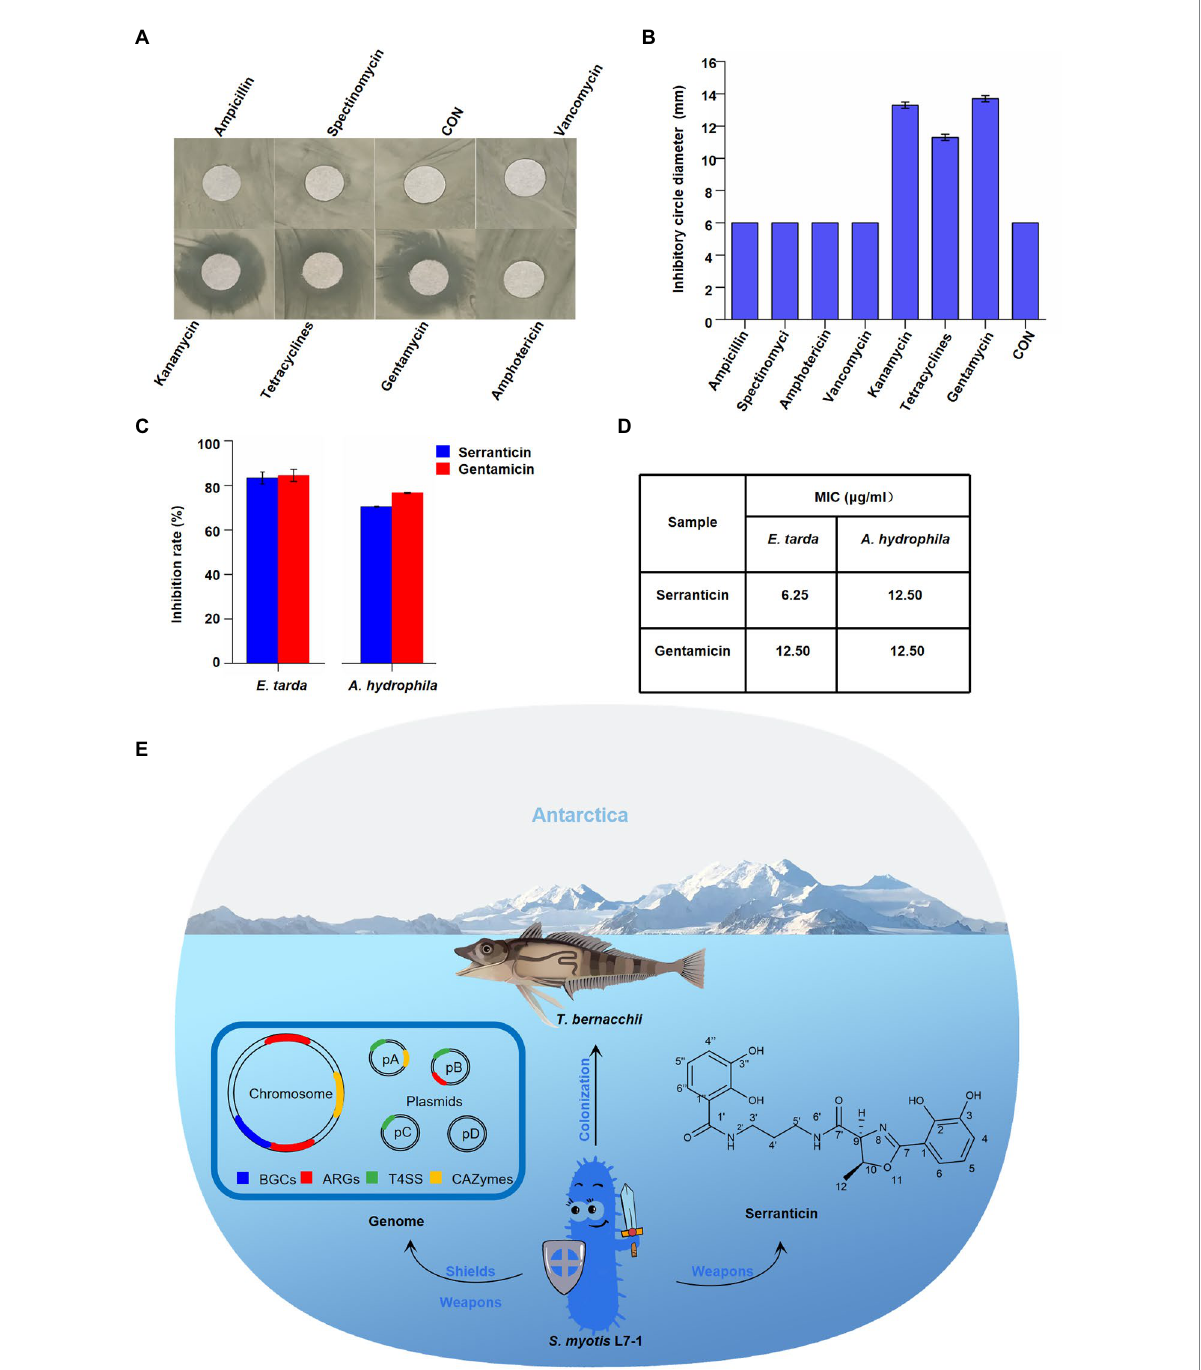
FIGURE 6 Effect of serranticin on bacteria antagonism. (A) Zone of inhibition of S. myotis L7-1 by antibiotics. (B) Antibiotic resistance activity of S. myotis L7-1. The diameter of circular filter paper sheets was 6 mm. Dates are the mean ± s.d. The experiments were repeated tree times with similar results. Origin 2022 (C) , In-vitro antimicrobial activity of the serranticin. Dates are the mean ± s.d. The experiments were repeated tree times with similar results. Blue squares serranticin, rad squares Gentamicin. Origin 2022. (D) The MIC values for inhibition of aquatic pathogenic bacteria of serranticin and the standard Gentamicin. Origin 2022. (E) Diagram illustrating how S. myotis L7-1 from T. bernacchii helps hosts adapt to the extreme Antarctic environment and resist pathogenic bacteria through the unique genomic features and production of